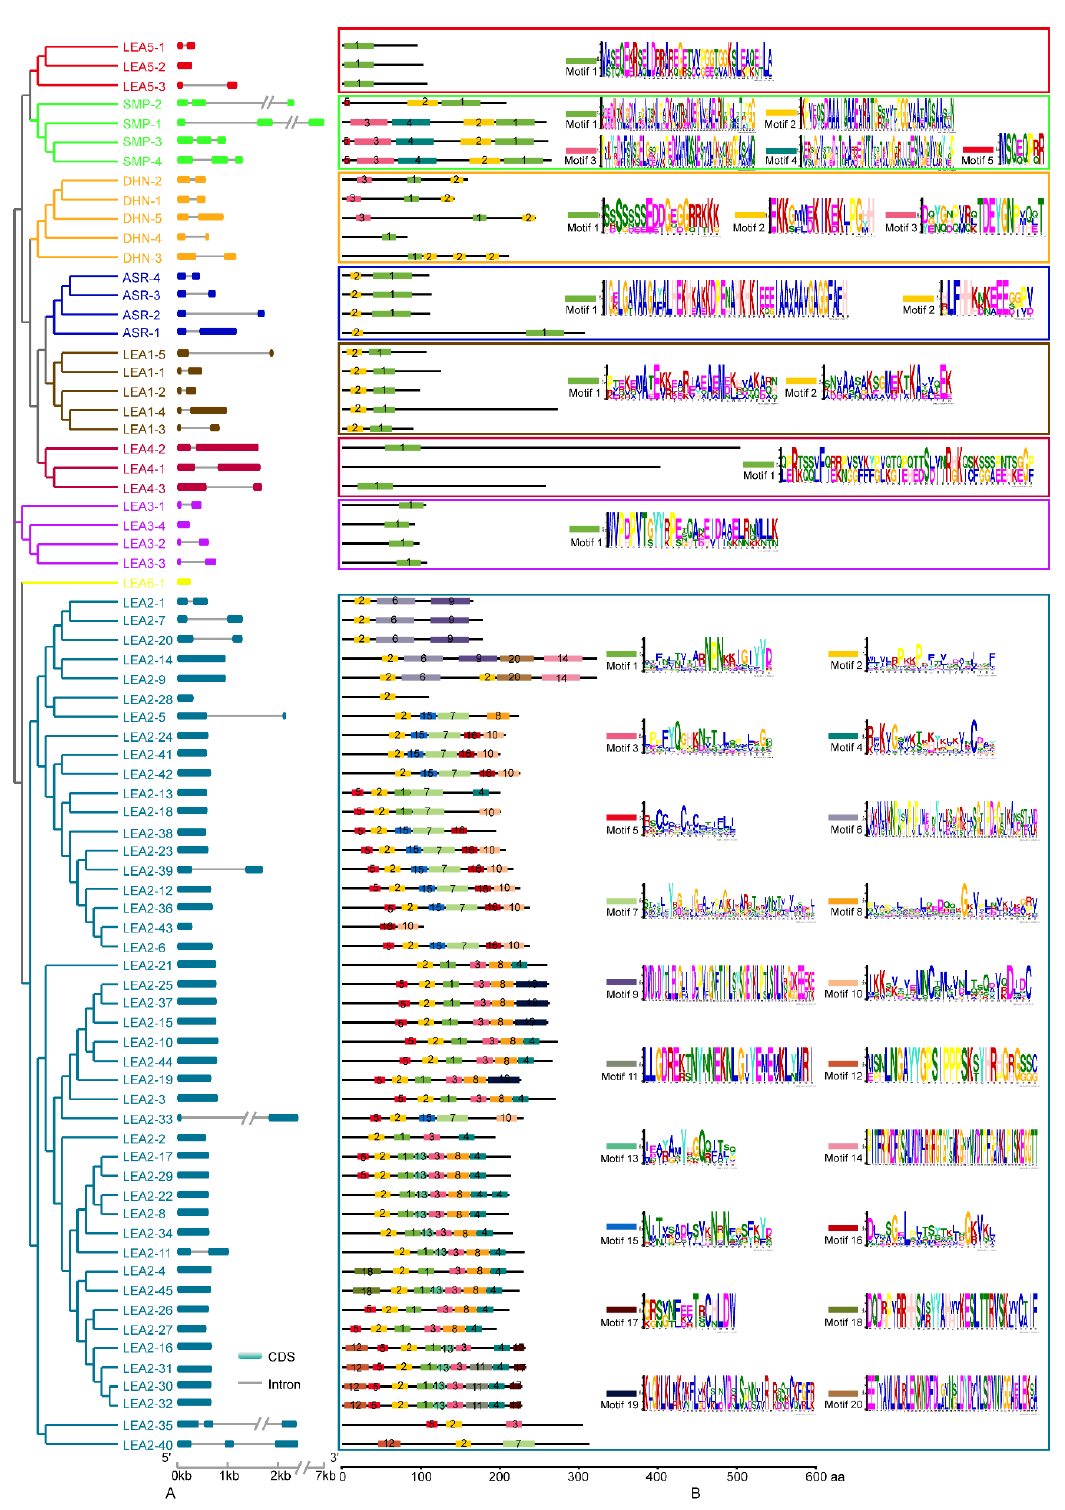
Figure 2. Exon-intron structure and motif distribution of the StLEA genes in the potato. ( A ), phylogenetic relationship and exon-intron structure, exon-intron are indicated by wide color bar and gray line, respectively. ( B ), Motif distribution, which was predicted by MEME online